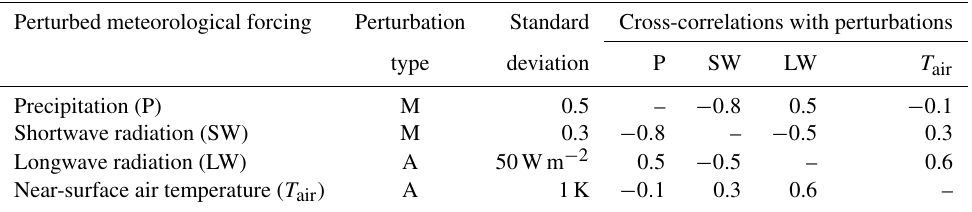
Table B1. Perturbation parameters applied to meteorological forcing fields for both the open-loop and data assimilation simulations. M is multiplicative, and A is